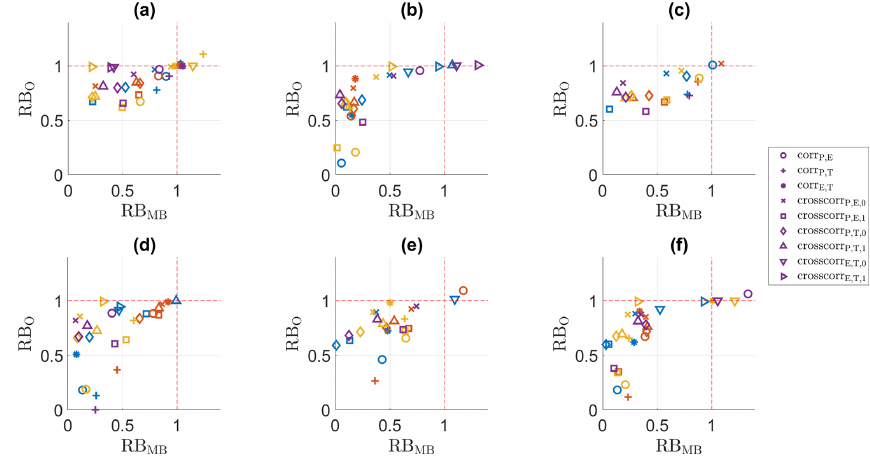
Figure 9. RB MB versus RB 0 for the precipitation occurrence indices in the validation period. (a) QDM, (b) mQDM, (c) MBCn, (d) MRQNBC, (e) dOTC, (f) R 2 D 2 . Winter: blue, spring: ochre, summer: yellow, autumn: